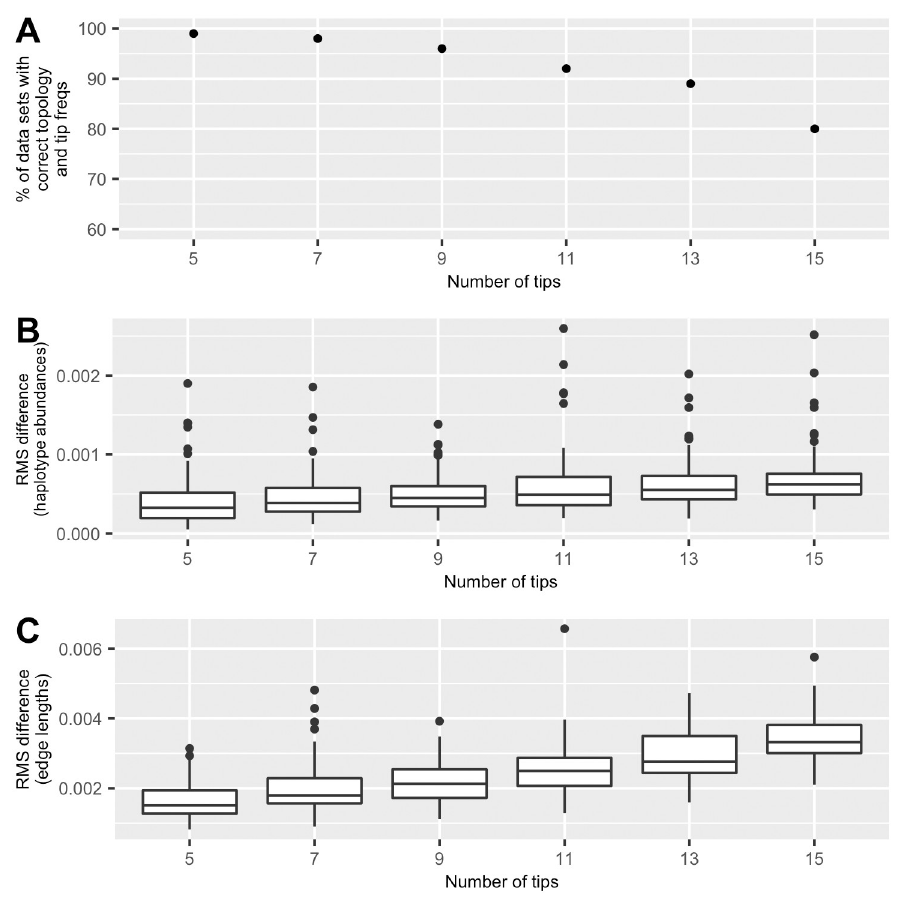
Fig 5. Performance of AFPhyloMix on simulated data. (A) Accuracy of AFPhyloMix—The percentage of data sets (out of 100), for different number of haplotypes, with correct estimated topologies and predicted tip relative abundances. (B) Root-mean-square differences between the actual- and the predicted tip relative abundances. (C) Root-mean-square differences between the actual and the predicated edge lengths. The accuracy decreased gradually while the variation between the estimated and the actual haplotype relative abundances and the edge lengths increased with the number of tips.